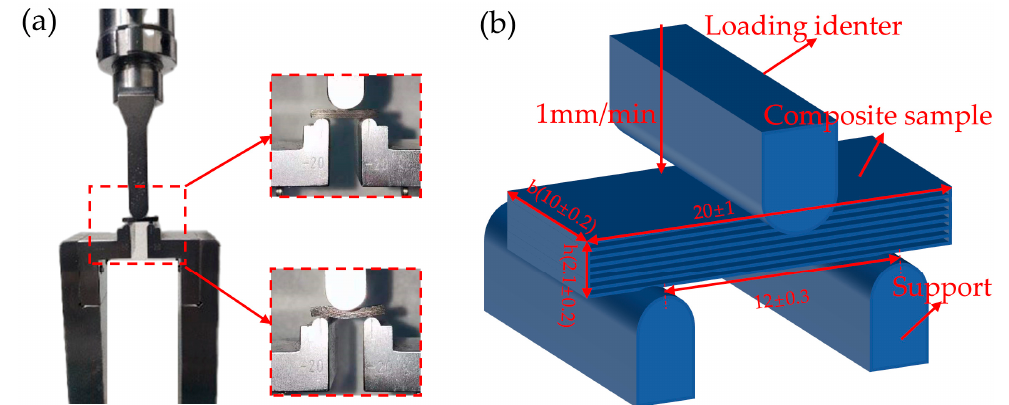
Figure 3. Short beam three ‐ point bending test, ( a ) actual testing process, ( b ) sketch of short beam three ‐ point bend.